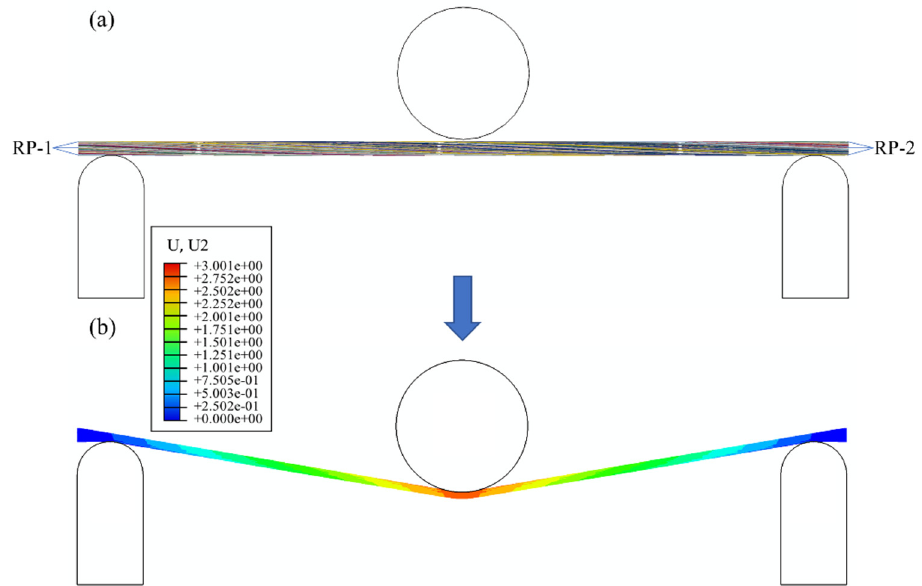
Figure 5. The bending simulation of the yarn: ( a ) boundary condition and ( b ) simulation result.